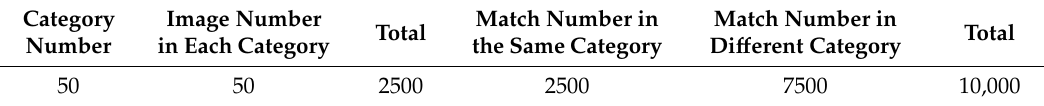
Table 4. The number of iris categories and the number of single-category